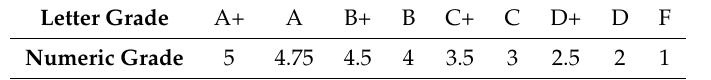
Table 1. Conversion table from ordinal to numerical value for letter grades (defined by the university).